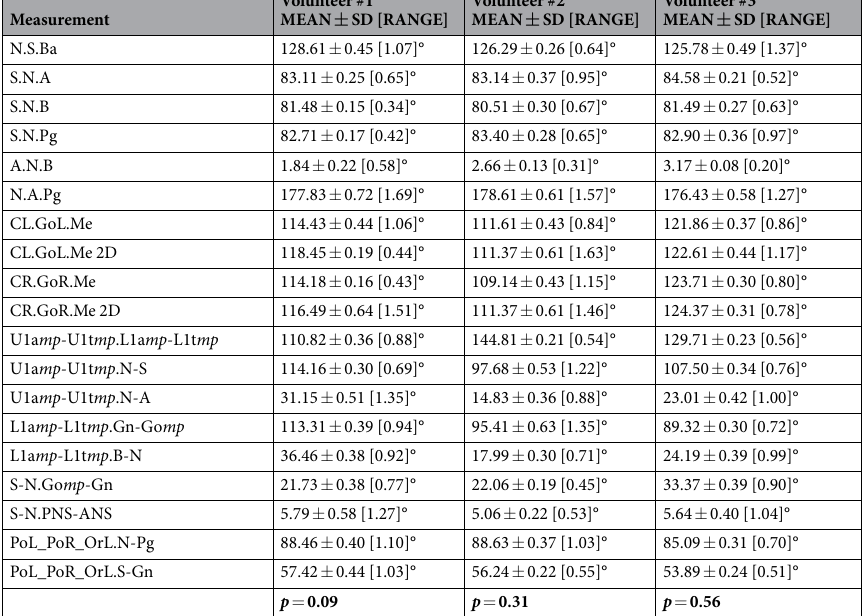
Abbreviations/definitions for cephalometric landmarks and planes are given in the legend of Fig. 4. 2D = two- dimensional; SD = standard